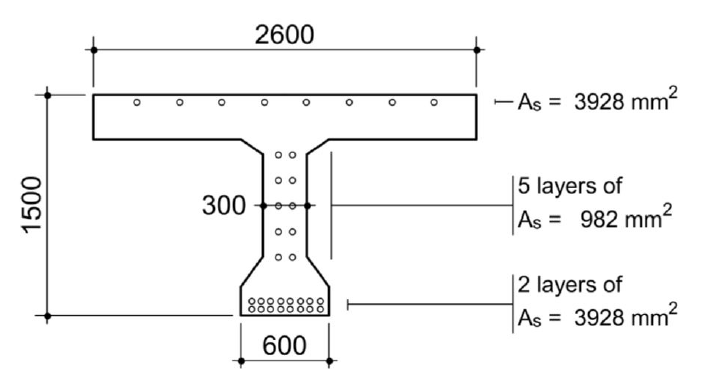
Figure 13. Bridge cross section.